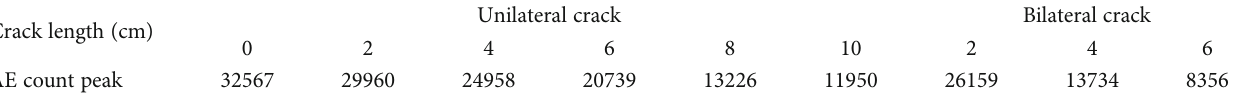
Table 2: Peak value of AE count of rock specimens with di ff erent cracks.